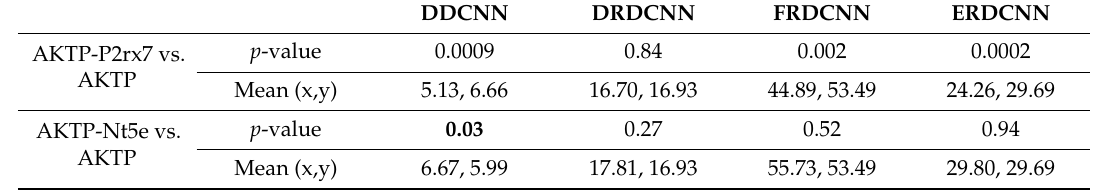
Figure 3. Cell counts predicted by the four models vs. their true cell counts based on the 100 test images. Predictions made by the ERDCNN model were closer to the true cell counts; especially for those images with smaller cell counts (e.g., the number of cells is smaller than 100).